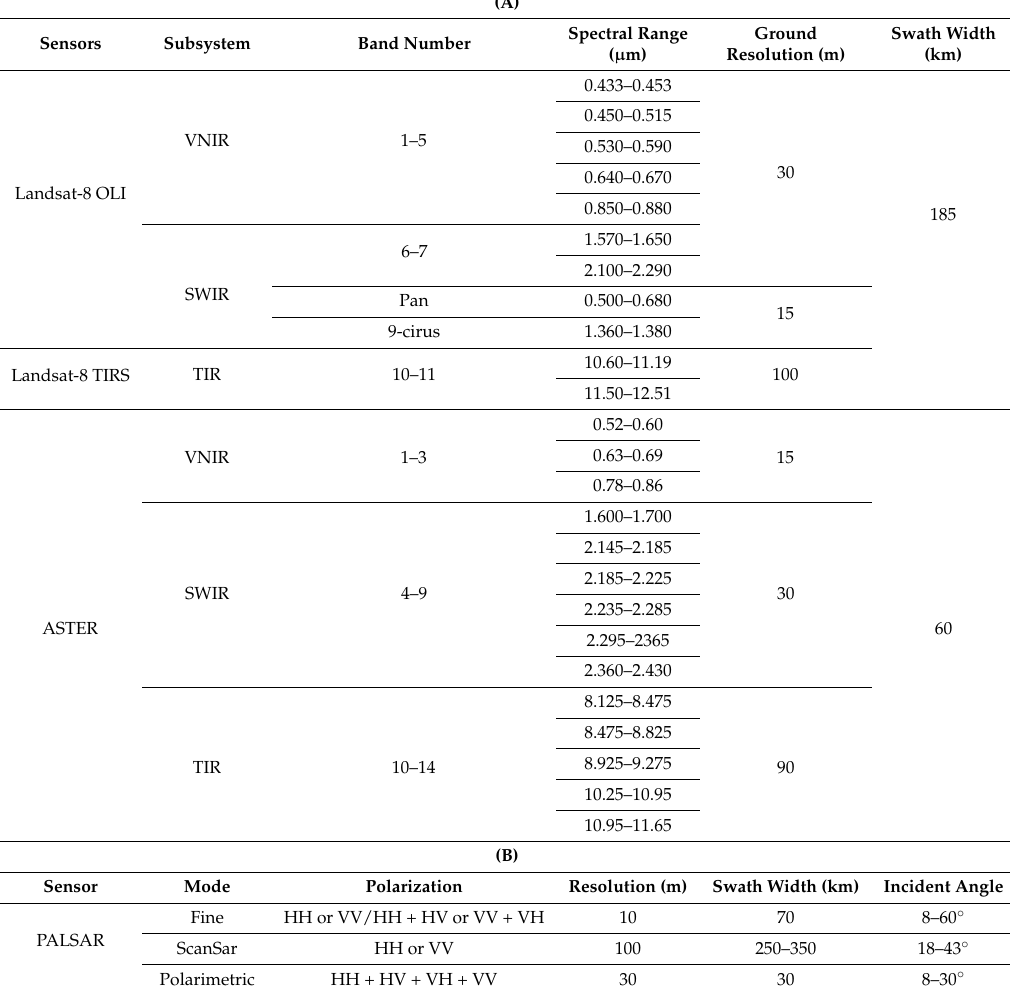
Table 2. The technical characteristics of Landsat-8 and ASTER (A) [37,38] and PALSAR (B)